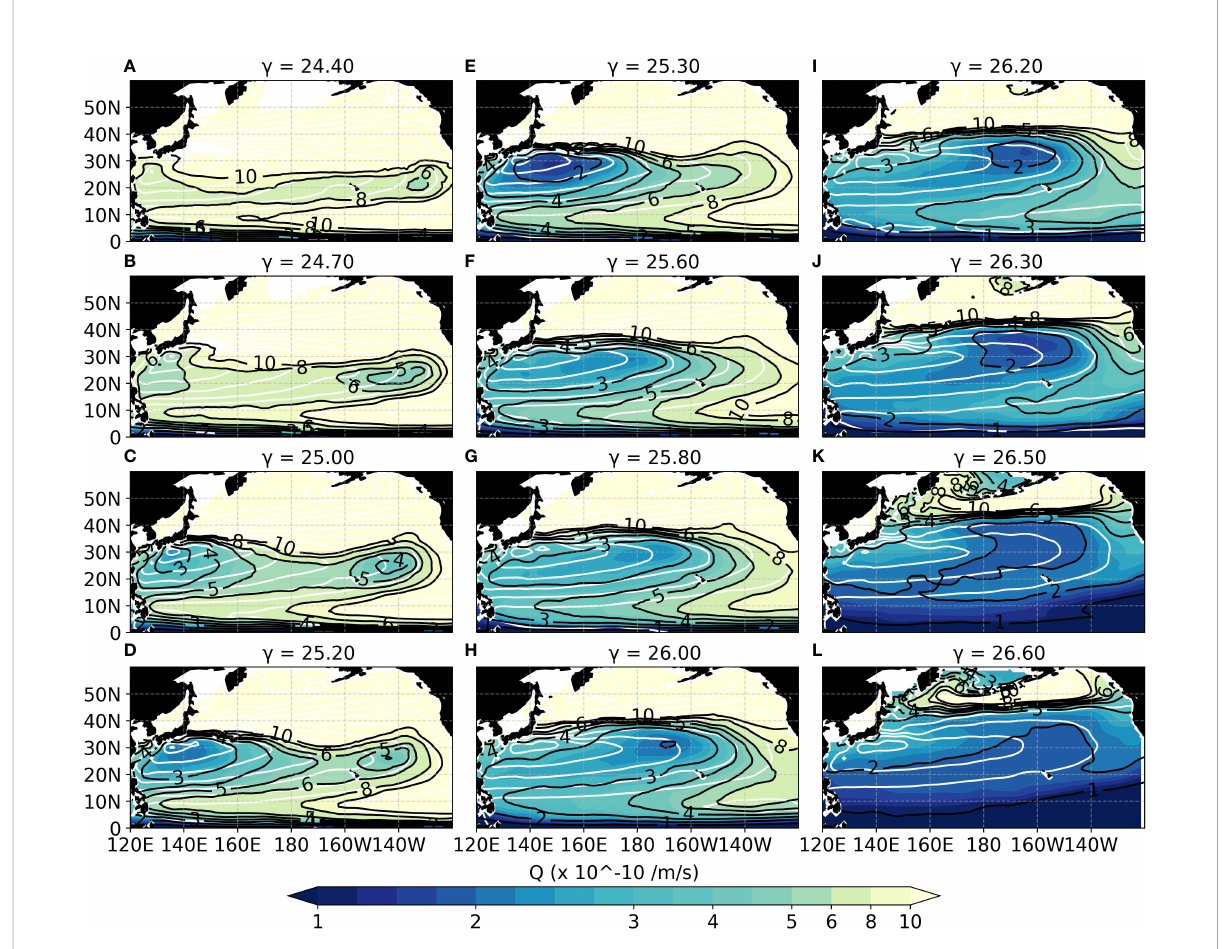
FIGURE 3 Climatological potential vorticity values (Q) (unit = 10 − 10 m − 1 s − 1 ) on surfaces g = (A) 24.40, (B) 24.70, (C) 25.00, (D) 25.20, (E) 25.30, (F) 25.60, (G) 25.80, (H) 26.00, (I) 26.20, (J) 26.30, (K) 26.50, and (L) 26.60. Black contours are for Q = 1, 2, 3, 4, 5, 6, 8, and 10 × 10 − 10 m − 1 s − 1 . Colors in 1× 10 − 10 < Q < 3 × 10 − 10 m − 1 s − 1 changed every 0.25 × 10 − 10 m − 1 s − 1 . The colors in 3 × 10 − 10 < Q < 5 × 10 − 10 m − 1 s − 1 changed every 0.5 × 10 − 10 m − 1 s − 1 . White contours denote isopycnal geostrophic stream function that is relative to 1500 dbar with an interval of 1 m 2 s − 2 . Purple, pink, and red circle indicates the core of ESTMW, STMW, and CMW